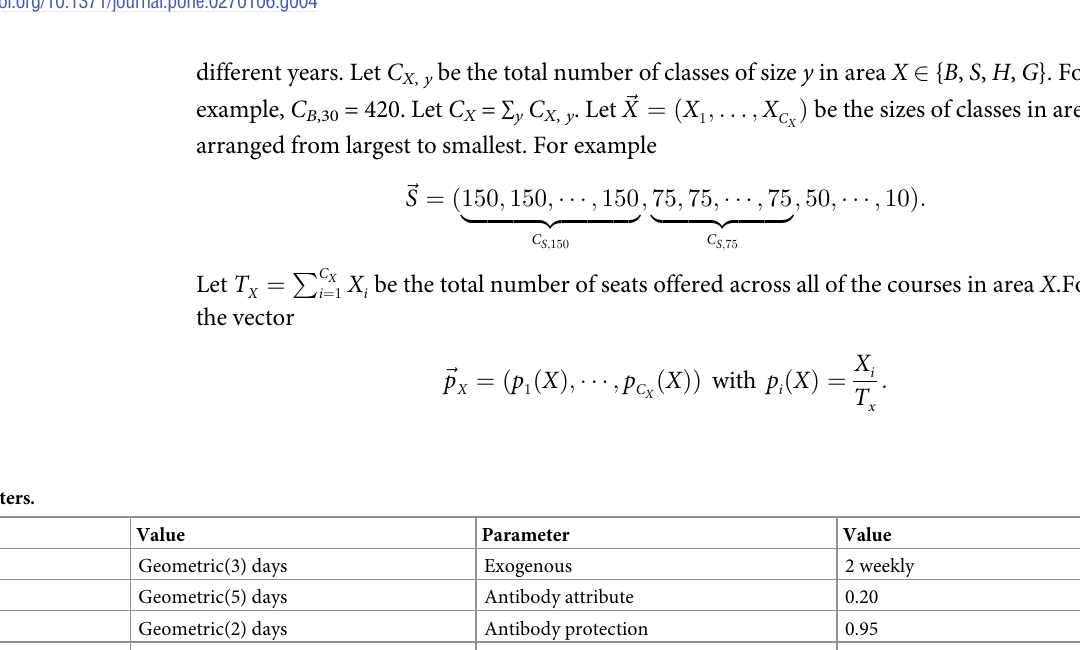
Fig 4. Total infections by source in our base model with R 0 = 3 and no vaccination.